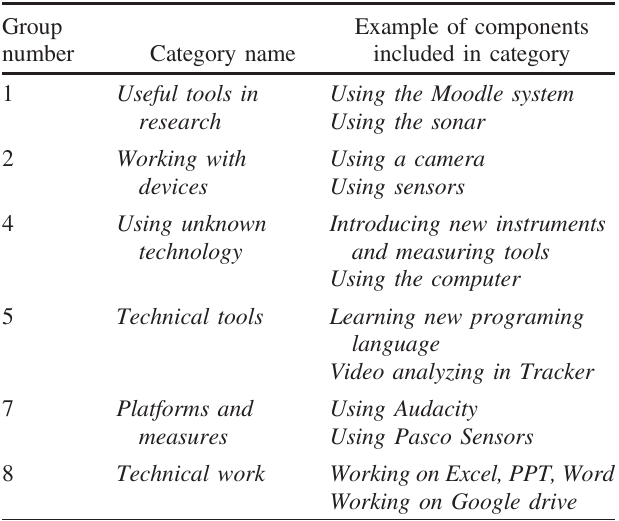
TABLE II. Student-categories corresponding to the top-down category “ research tools ” and examples for components included in